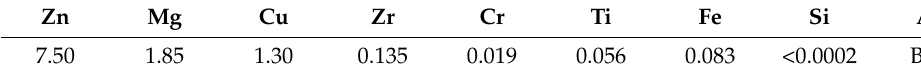
Table 1. Chemical composition of the base metal used in this study (weight %).